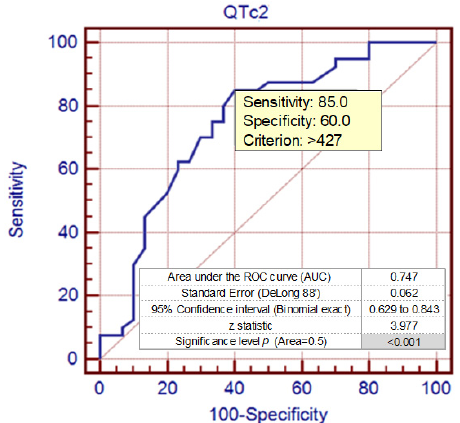
Figure 6. The ROC curve (AUC) analysis for QTc intervals [ms] in the syncopal group and control group in the upright phase during the HUTT—Phase 2 (TpTe2).